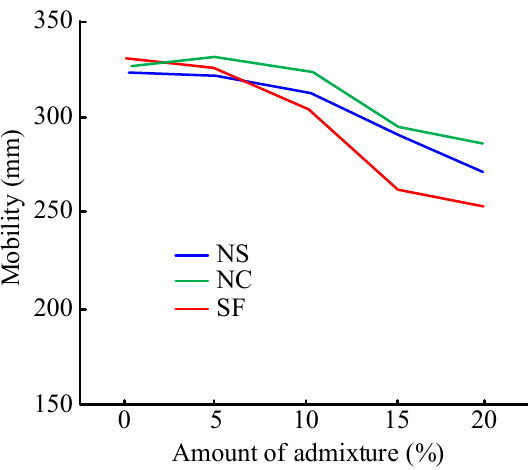
Figure 5. Cement paste fluidity of pervious concrete.